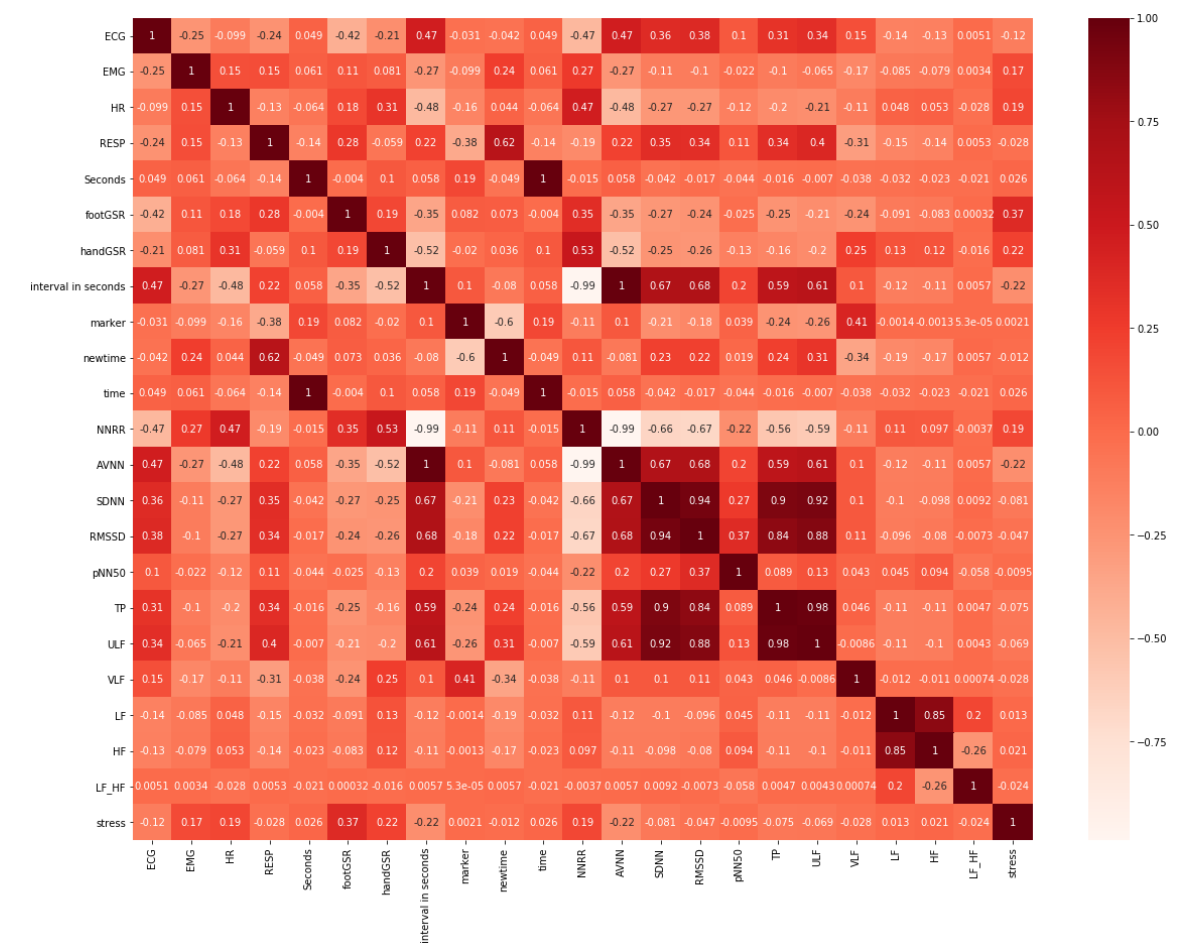
Sensors 2021 , 21 , 2873